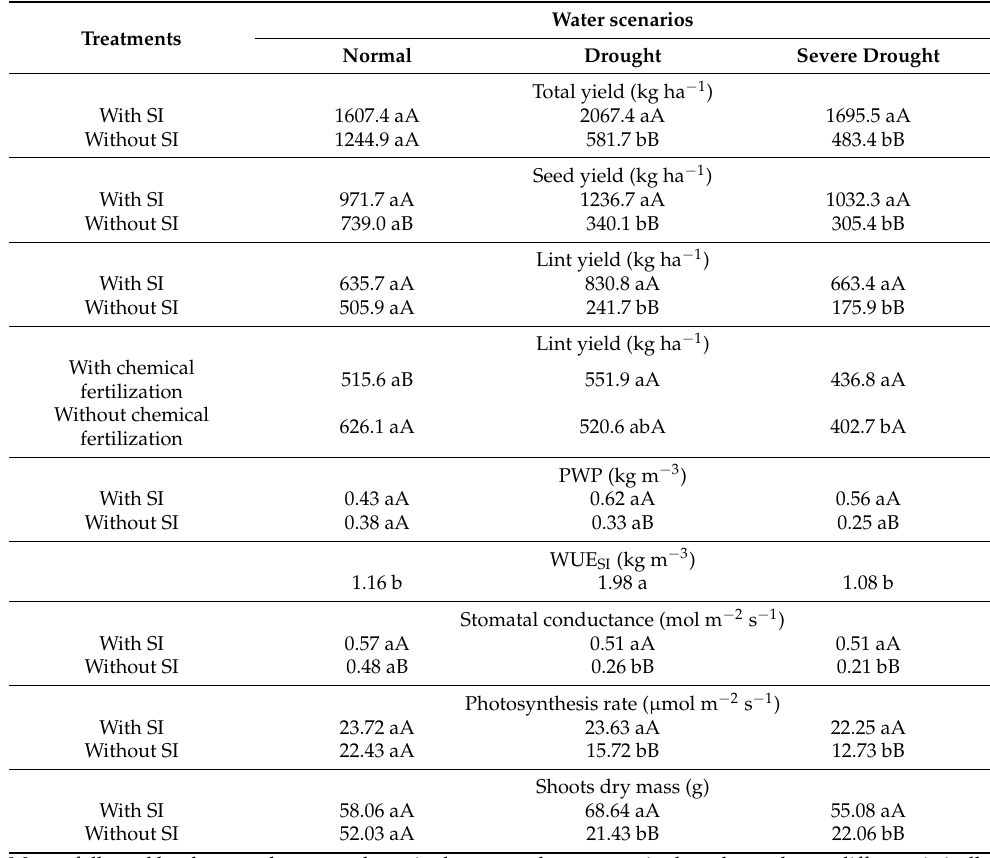
Table 4. Cotton yields (total, seed, and lint), physical water productivity (PWP), the efficiency of supplemental irrigation (WUE SI ), stomatal conductance (gs), photosynthesis rate ( A ), and shoots’ dry mass as a function of water scenarios, supplemental irrigation (SI) with treated wastewater, and with or without chemical